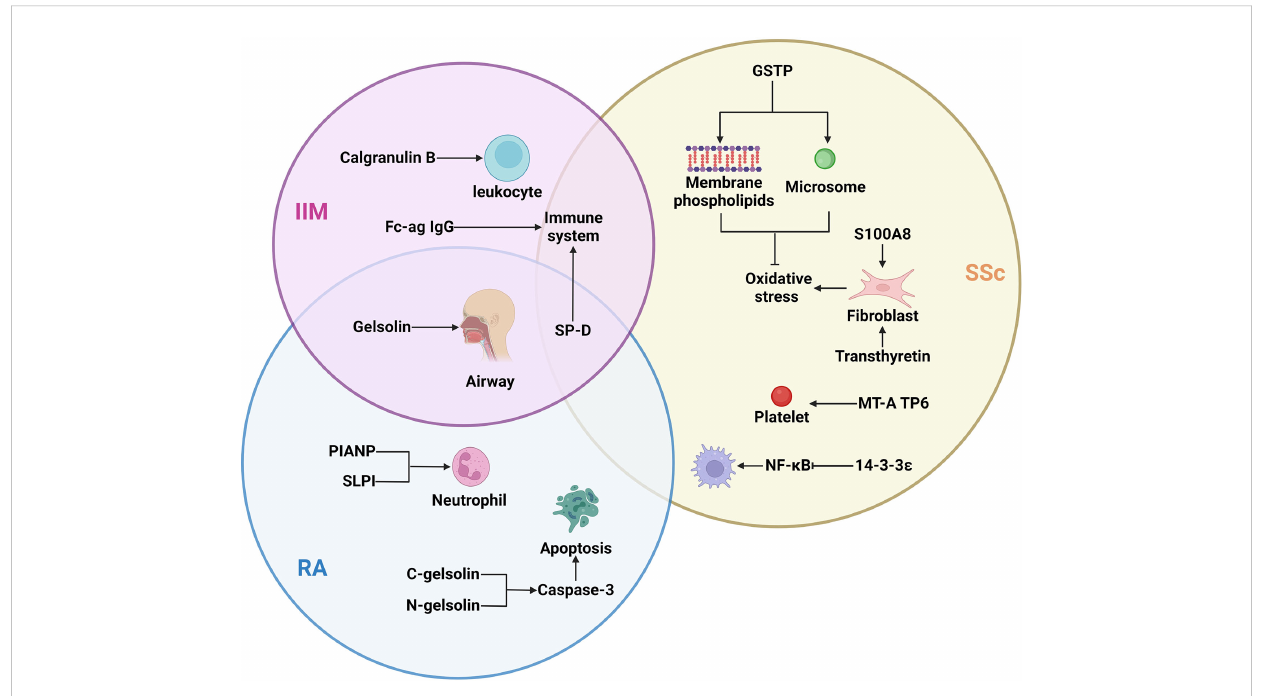
FIGURE 1 The important proteins of different subtypes of ILD and their target cells/organs: Different subtypes of ILD had different expression proteins, but SP- D differences were found in the three types of ILD, gelsolin differences were found in IIM and RA. IIM, idiopathic in fl ammatory myopathies; Fc-ag IgG, Fc-agalactosylated glycan of IgG; SP-D, surfactant protein D; SSc, systemic sclerosis; GSTP, glutathione S-transferase P; RA, rheumatoid arthritis; PIANP, paired immunoglobulin-like type two receptor-associated neural protein; SLPI, secretory leukocyte peptidase